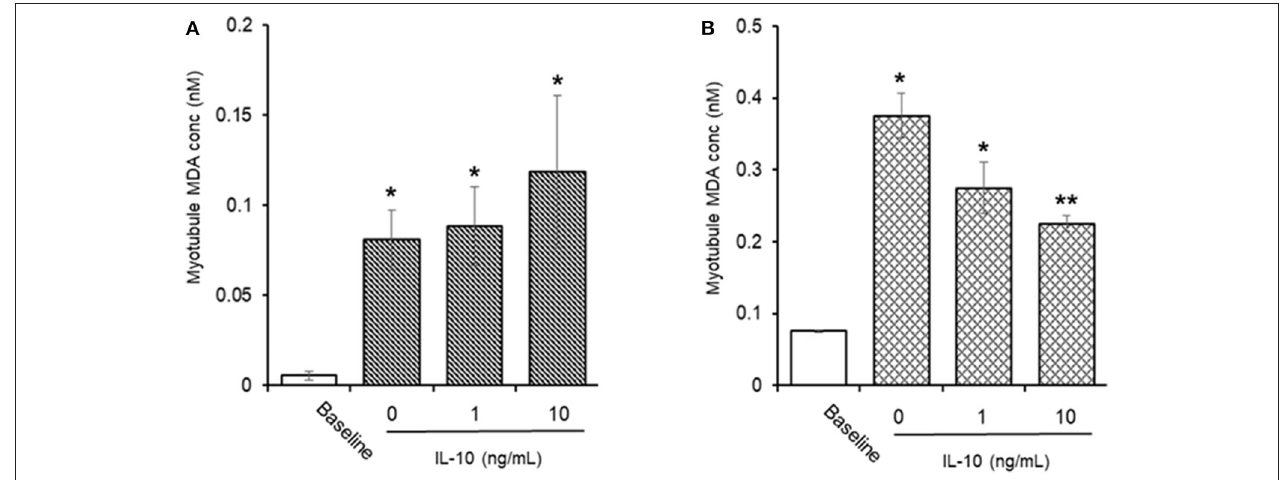
FIGURE 9 | Direct (A) or indirect (B) antioxidant effect of IL-10 on AAPH-stimulated malondialdehyde (MDA) content in differentiated mouse myotubules. Results are mean ± SEM of 6 separate experiments. * p < 0.05 and ** p < 0.05 represents statistical difference from un-stimulated (baseline) or AAPH-stimulated myotubule MDA content,